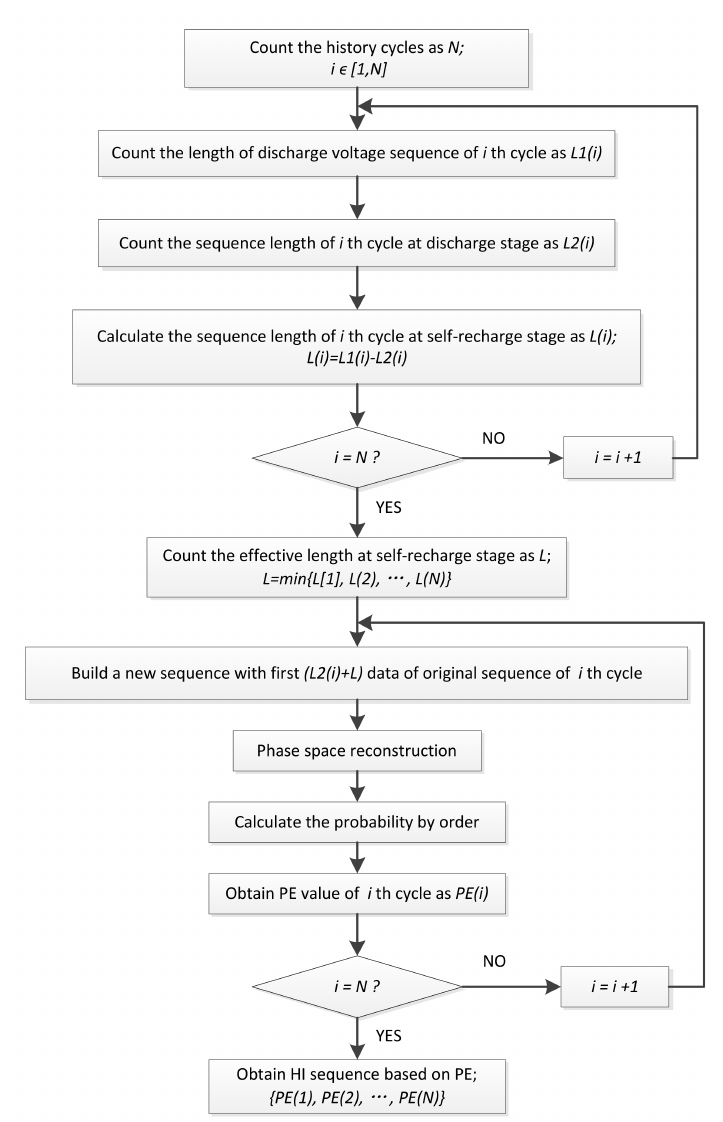
Figure 3. Flow chart of health indicator (HI) extraction based on permutation entropy